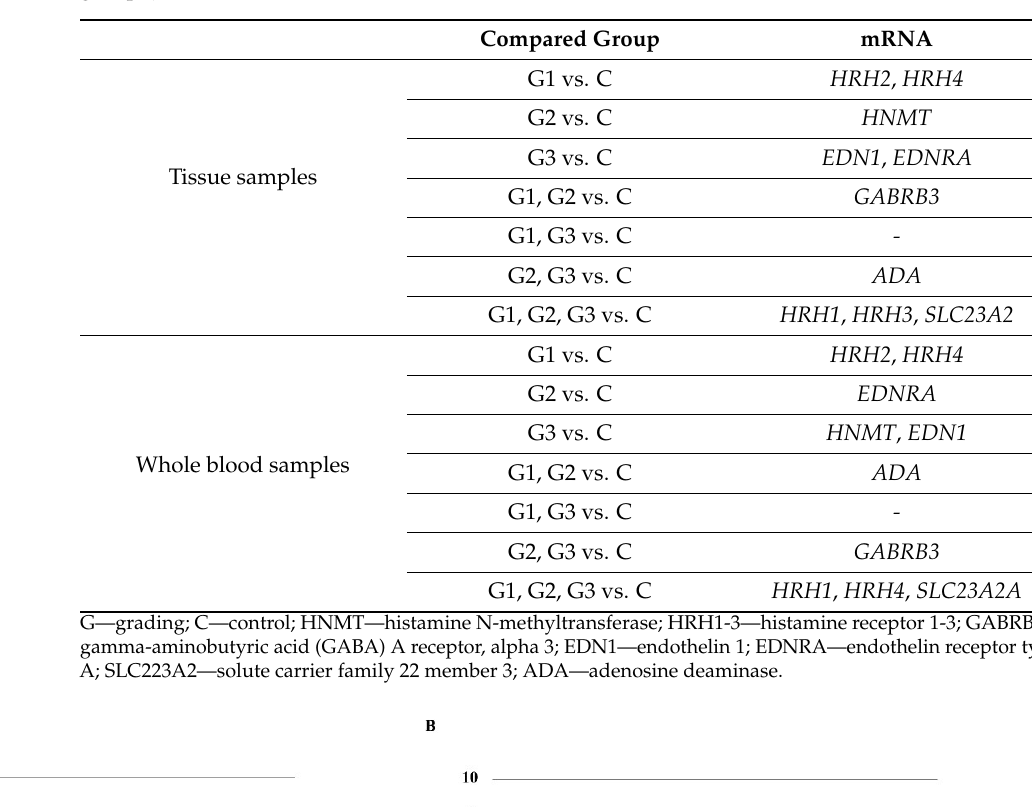
Table 5. Transcripts of genes associated with the histaminergic system, differentiating the tissue and whole blood samples obtained from patients with endometrial cancer in comparison to the control group ( p < 0.05).